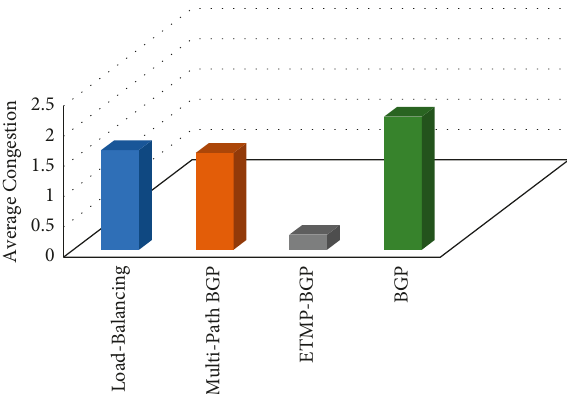
Figure 15: Comparison of routing methods (LB � load balancing, MBGP � multipath BGP-4)